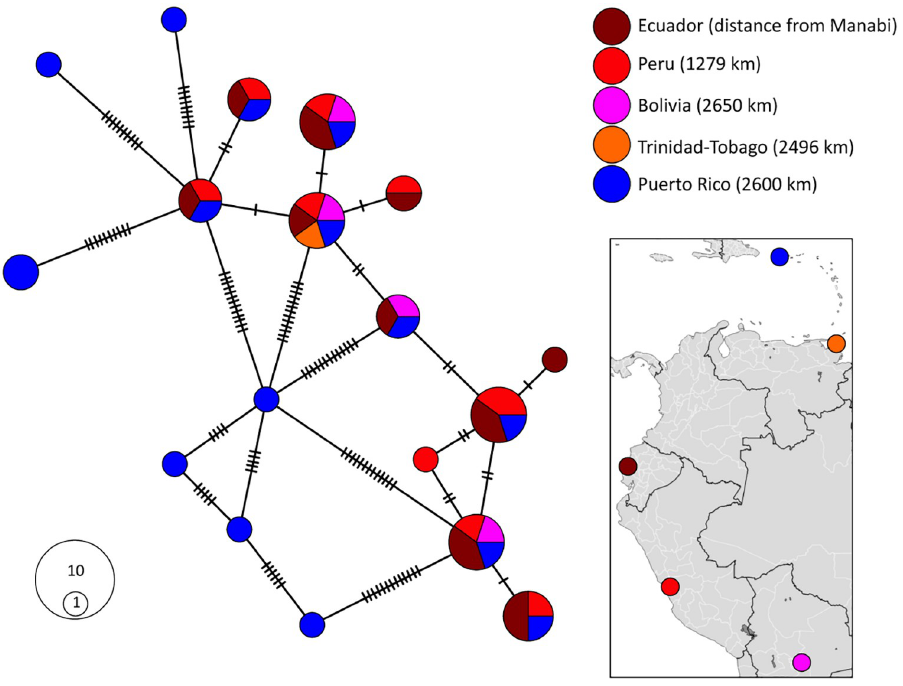
Fig 5. Haplotype network analysis using the Tpie4i4 segment of the Tpi gene illustrating the genetic differences between the haplotypes found in Ecuador, Peru, Bolivia, Trinidad-Tobago, and Puerto Rico. Kilometers in parenthesis indicate distance from Manabi, Eucador. Circle area proportional to number of haplotypes.